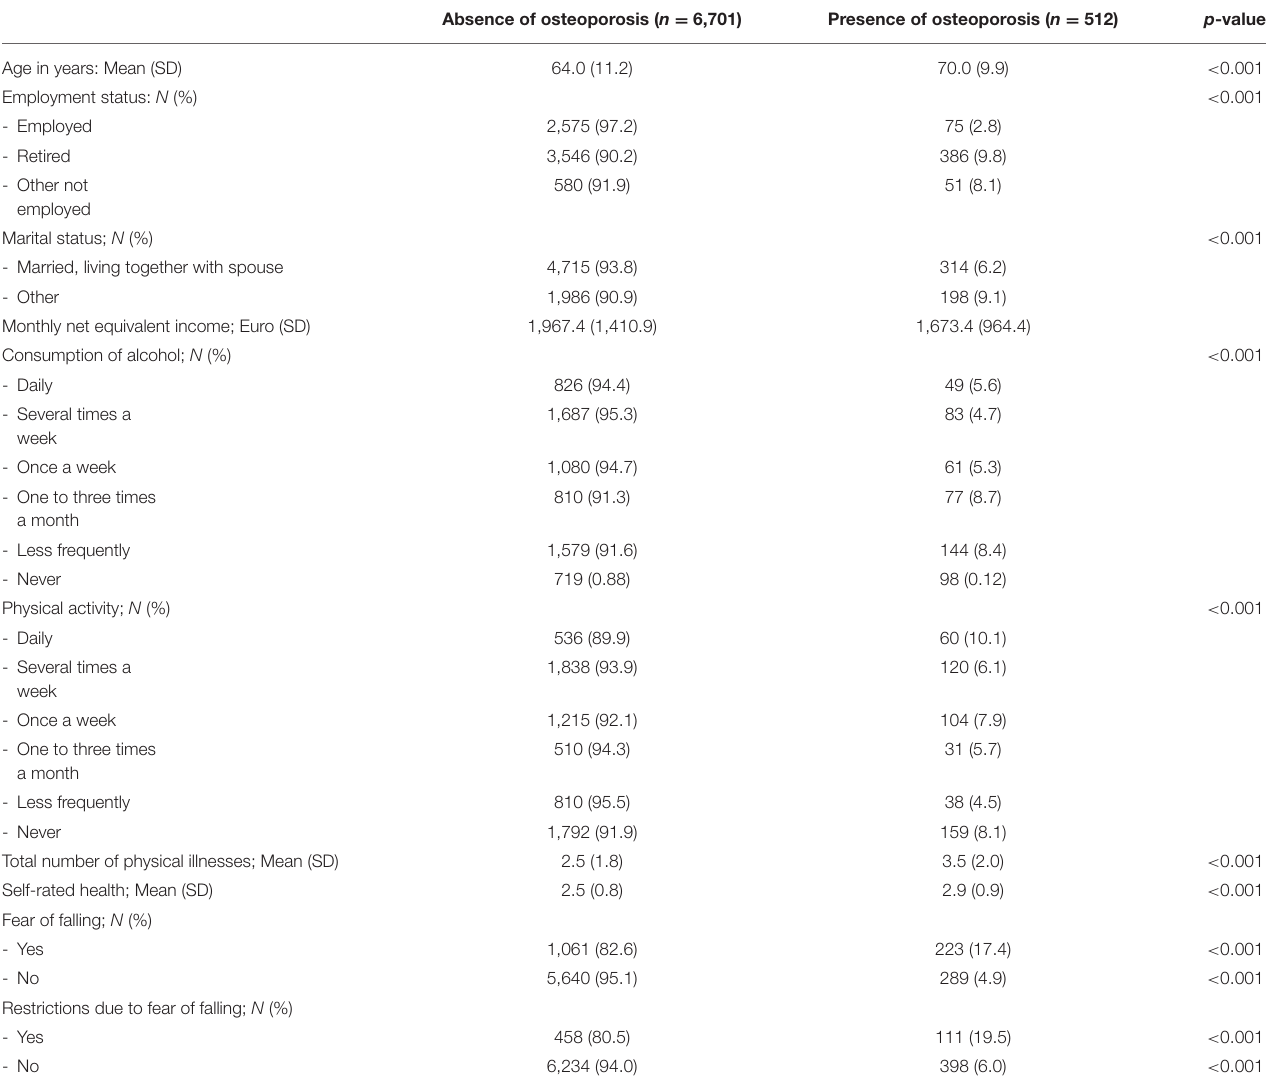
TABLE 1 | Characteristics, stratified by diagnosed osteoporosis (No; Yes) ( n = 7,213). Absence of osteoporosis ( n = 6,701) Presence of osteoporosis ( n = 512) p